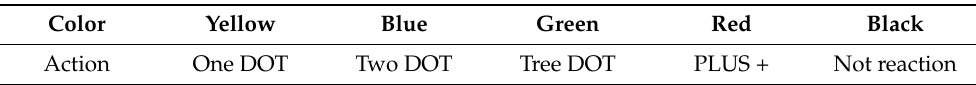
Table 2. Reaction of the robot assigned to the read color, to mark the corresponding symbol on the detected color using a marker pen. Color Yellow Blue Green Red Black Action One DOT Two DOT Tree DOT PLUS + Not reaction